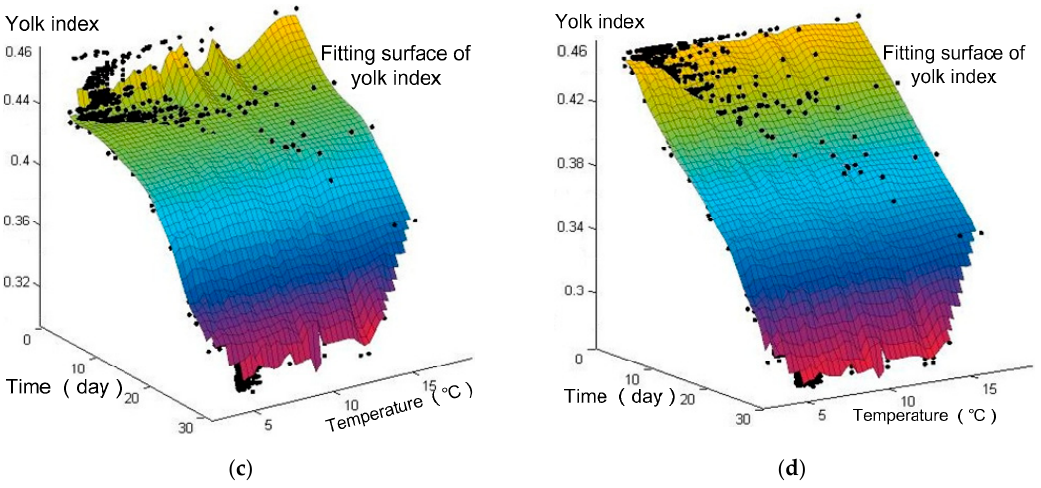
Figure 7. Yolk index changes of n-3 PUFAs enriched and conventional eggs under different conditions. ( a ) Yolk index changes of n-3 PUFAs enriched eggs under room temperature; ( b ) Yolk index changes of conventional eggs under room temperature; ( c ) Yolk index changes of n-3 PUFAs enriched eggs in refrigeration; ( d ) Yolk index changes of conventional eggs in refrigeration.